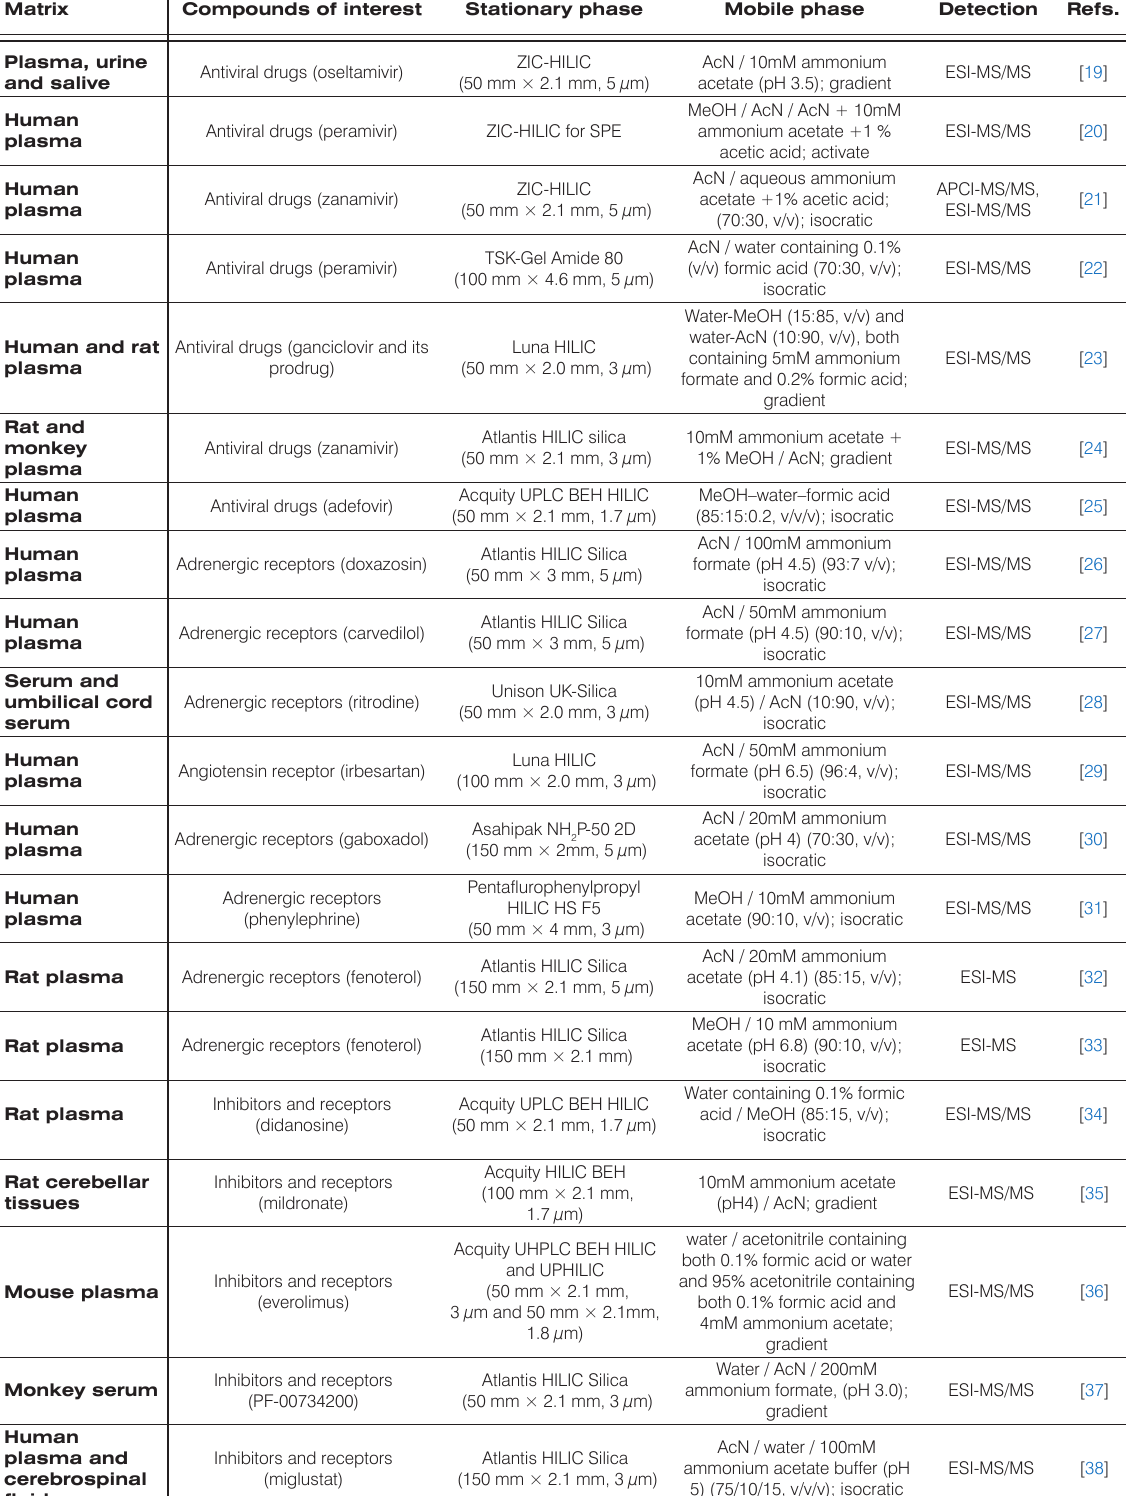
Table 1. - HILIC applications in the analysis of biological